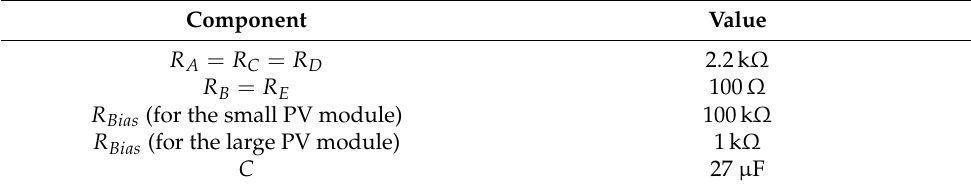
Figure 20. The measurement setup for small-signal AC impedance measurements with a DC bias. Developed from [18]. Table 5. The values of the components employed in the Full Measurement Circuit. From